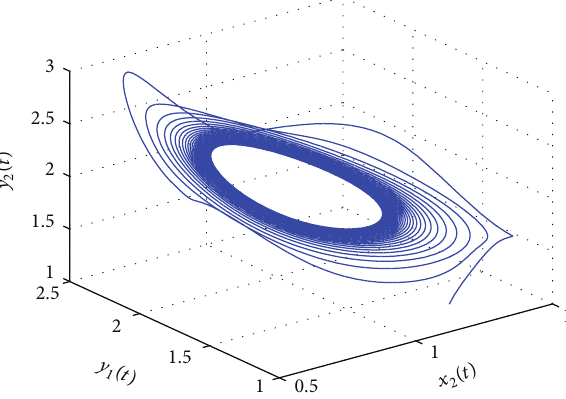
Figure 11: The phase plot of the states 𝑥 1 , 𝑥 2 , 𝑦 2 for 𝜏 2 = 10.7500 > = 9.9183 . 𝜏 20